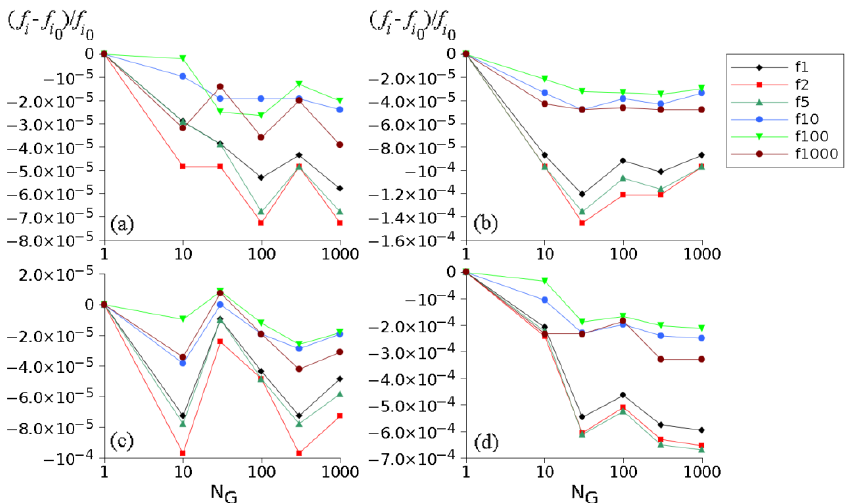
Figure 8. Graphs of relative variations of resonance frequencies for the ternary medium as a function of N G for the velocity surfaces in Figure 6 and velocity profiles in Figure 7. Here, f i 0 and f i are resonance frequencies with homogeneous ( N G = 1) and, respectively, grainy layer 2. The first resonance for N G = 1 is at 2068.36 Hz, while the next resonances are approximate multiples of it. The resonances No. 1,2,5,10,100 and 1000 were considered. ( a – d ) correspond to Equations (9a)–(9d) respectively.